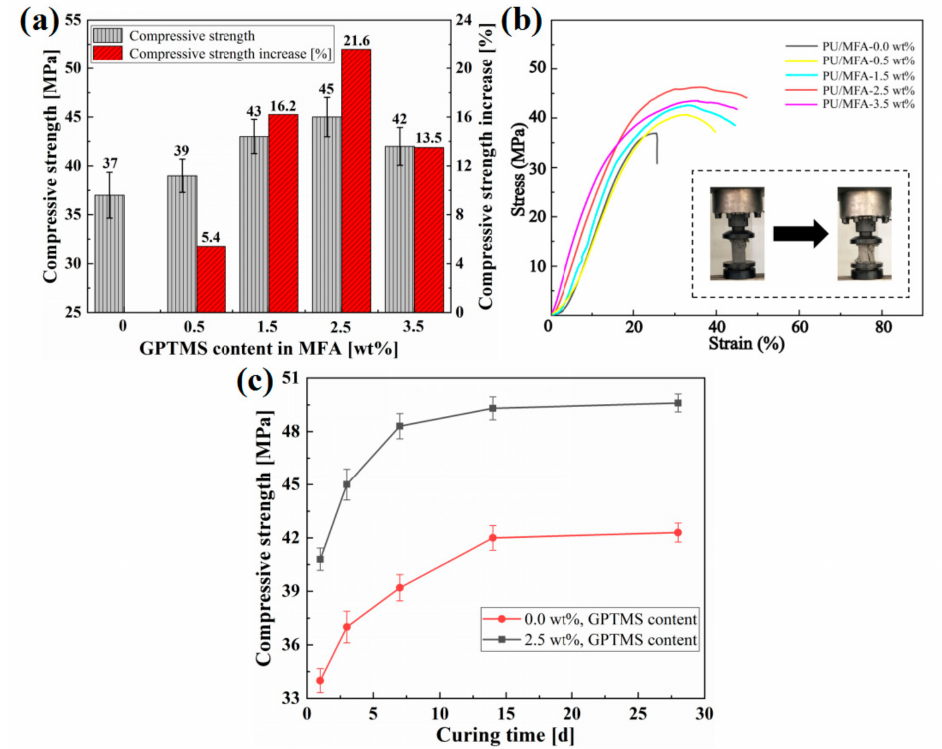
Figure5. ( a )Compressivestrengthof specimensunder di ff erentGPTMScontent inMFA; ( b )stress-strain curves of PU / MFA composites with di ff erent GPTMS contents; and ( c ) compressive strength of -0.0 wt. % and -2.5 wt. % PU / MFA specimens at di ff erent curing